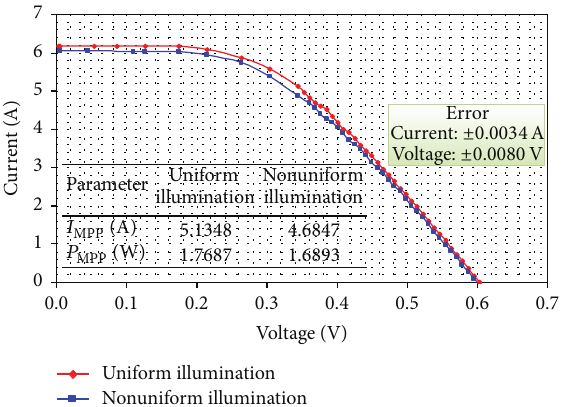
Figure7: 𝐼 - 𝑉 characteristicsforuniformandnonuniformillumina- tion of a single PV cell at medium energy concentration ratio. The peak energy flux concentration in the nonuniform illumination was 3.